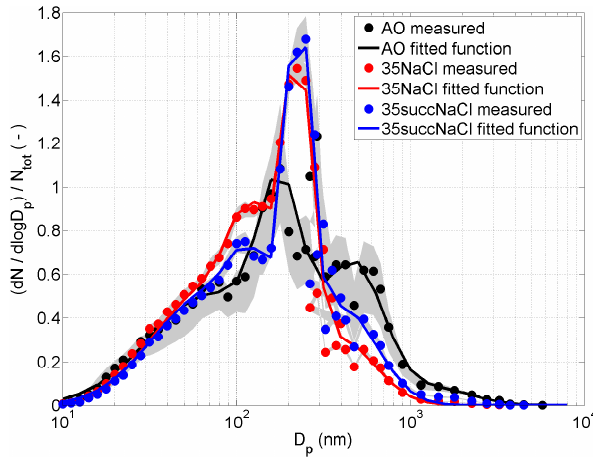
Fig. 8. Particle number size distributions for different succinic acid concentrations (RH mean = 23%). Water temperature medians are between 0.2 and − 0.2 ◦ C and medians of salinity between 35.4 and 35.5gkg − 1 . Measurement time per succinic acid concentration be- tween about 40 and 90min. Grey shaded areas indicate the area between the 75th and 25th percentiles. Table 4. Parameters for fitted lognormal aerosol number size dis- tributions with Nx as the number concentration (cm − 3 ), Dgx as the geometric diameter (µm) and σ x as the standard deviation for the different modes and succinic acid concentrations in the water: